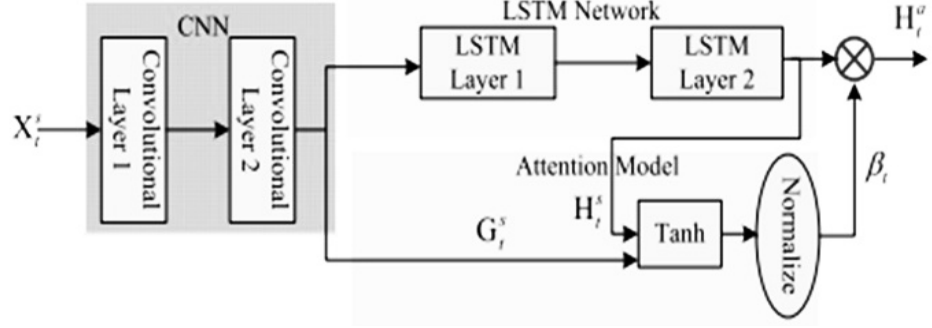
Figure 8. CNN-LSTMs Model is combination of Conv and LSTM.